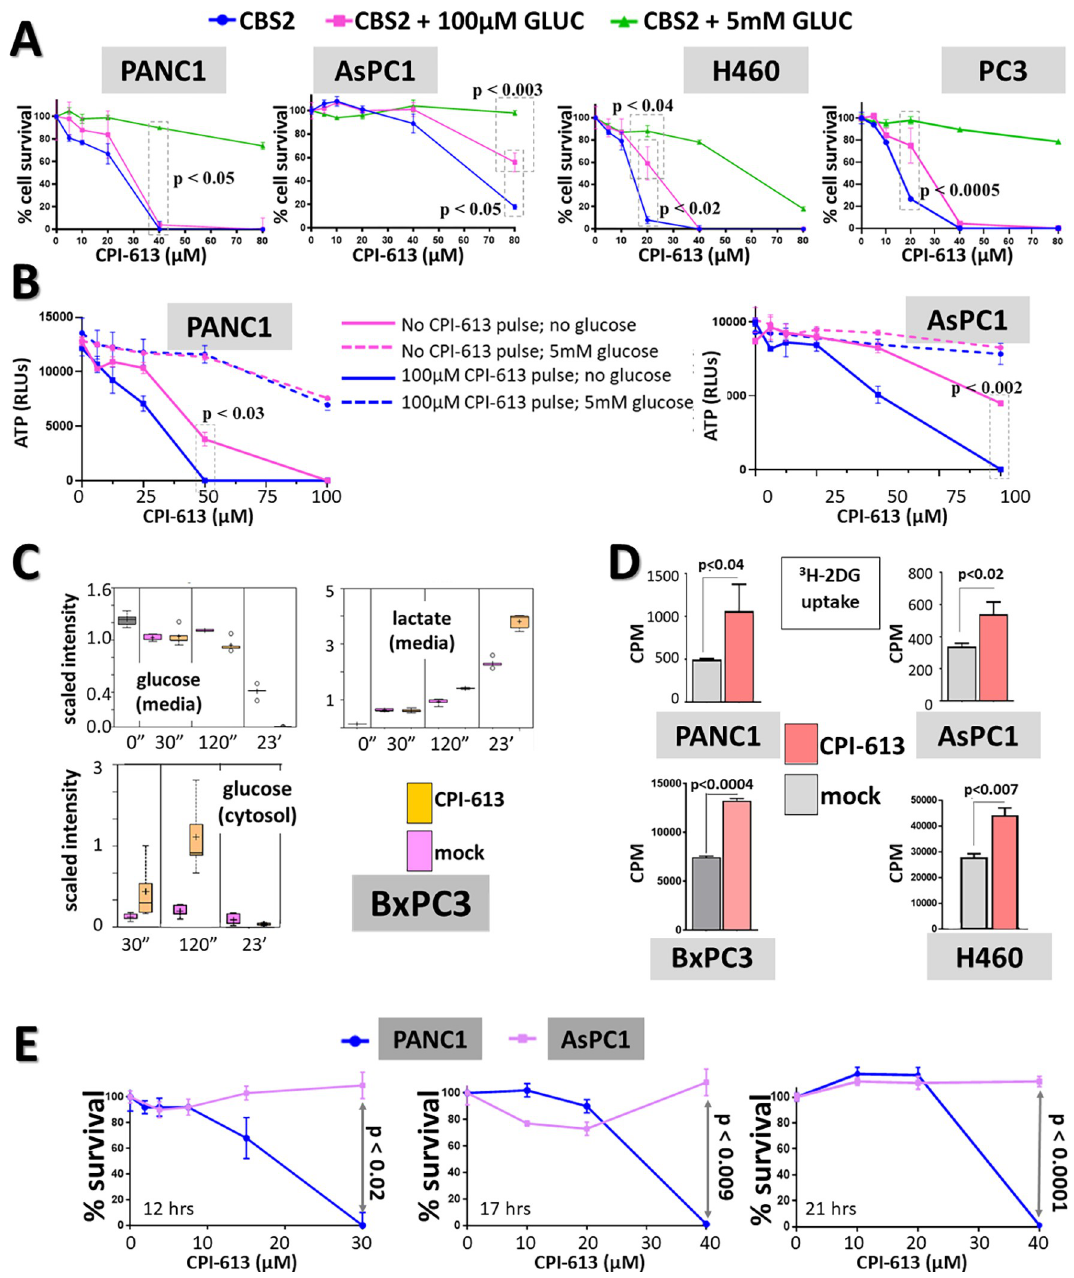
Fig 1. Assay systems show cell line variability in CPI-613 response; glucose effects; and drug modulation of glucose consumption. A: Sensitivity to CPI-613-induced cell death varies among carcinoma cell lines and is modulated by exogenous glucose availability . Four different cell lines were exposed for 15hrs (PANC1, AsPC1, H460) or 8hrs (PC3) at indicated concentrations of CPI- 613 in the absence of exogenous nutrients (in carbonate buffered balanced salts; henceforth CBS2; Materials and Methods). Glucose (GLUC) was added as indicated. Following treatment, cells recovered (24hrs) in complete medium without serum (henceforth CM/ ns). CellTiter-Glo ATP assay (Promega) was used to assess cell survival after this recovery. (See Materials and Methods and S1A Fig for details; also see S1B–S1D Fig for validation of this assay). p value in leftmost and rightmost panels refer to boxed green and blue points. B: Carcinoma cell death after two-hour exposure to 100μM CPI-613 followed by 19-hour exposure to CPI-613 dose ranging . Carcinoma cell lines were treated in the presence or absence 5mM glucose, then incubated for 23hrs in CM/ns to assess cell death (as in panel A). C: Glucose consumption and lactate generation (steady-state metabolomics) . Glucose levels and secretion of lactate were measured in BxPC3 PDAC cells treated with 240 μ M CPI-613 in complete culture medium for the times, in minutes or hours, shown (0 minutes indicates measurements on virgin media). Metabolite levels were measured by established LC/MS procedures and observed values are expressed using conventional scaled intensity units (see Materials and Methods and Supplementary Materials and